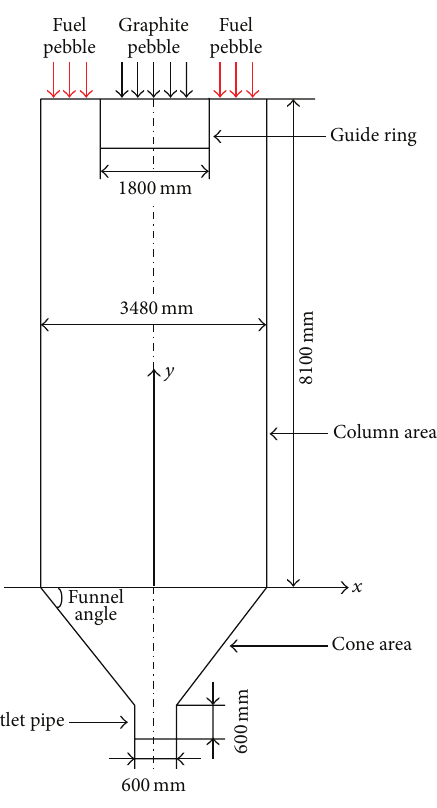
Figure 1: Schematic of modular pebble bed